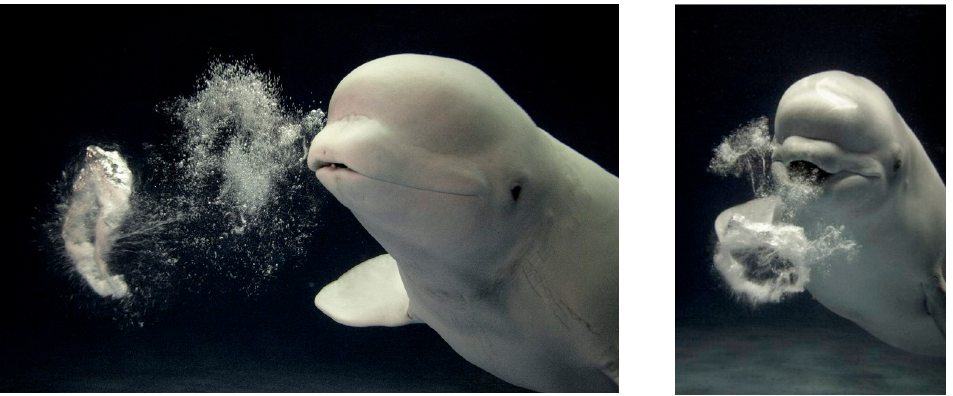
Figure 2. Two images of a beluga producing toroidal rings in water.